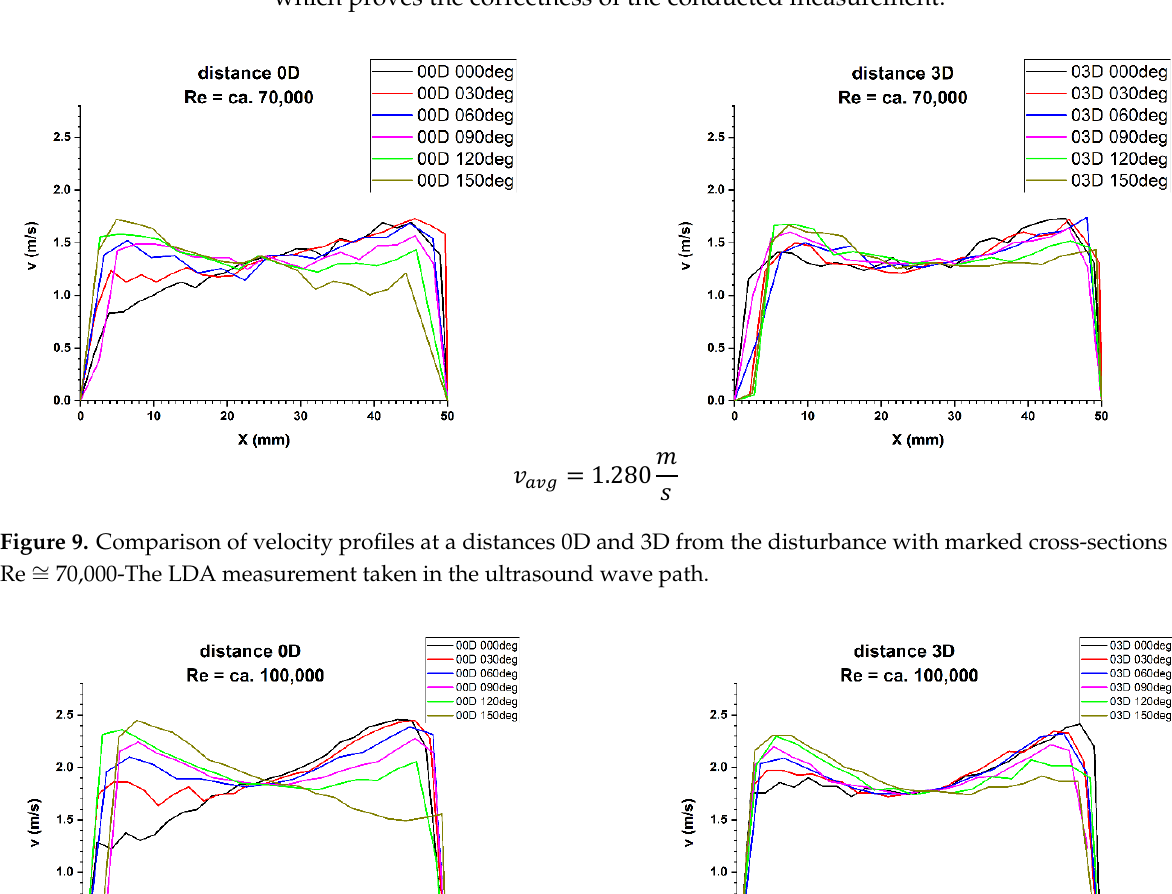
Figure 10. Comparison of velocity profiles at a distances 0D and 3D from the disturbance with marked cross-sections for Re ≅ 100,000-The LDA measurement taken in the ultrasound wave path.